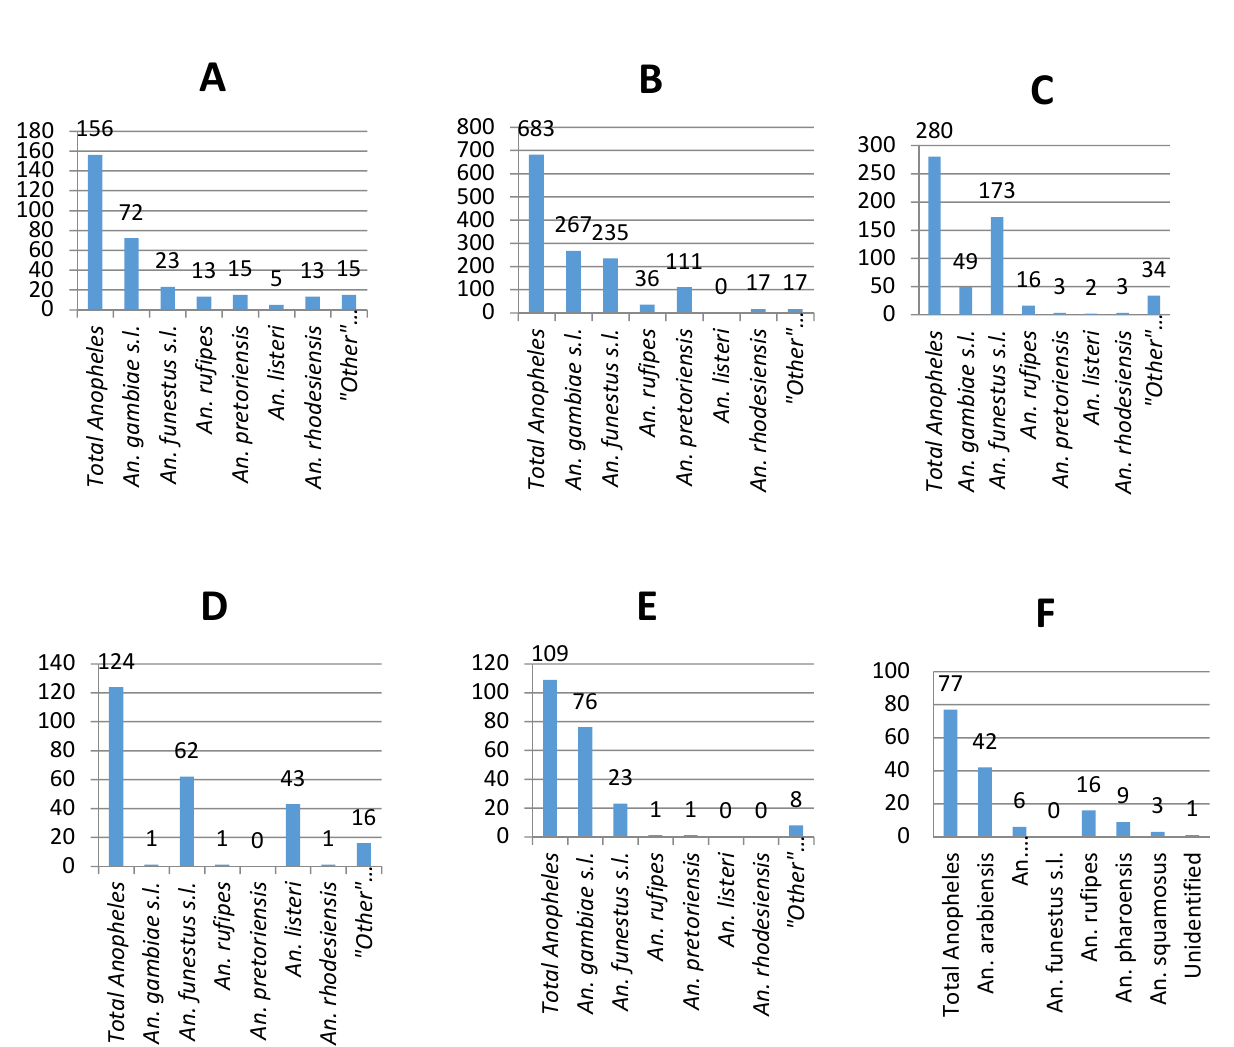
Figure 5. Adult Anopheles collected in 2017 / 18 at six localities: ( A ) Doreen Farms; ( B ) Bende Mutale; ( C ) Popallin Ranch; ( D ) Tshipise Resort; ( E ) Pafuri; ( F ) Malahlapanga.